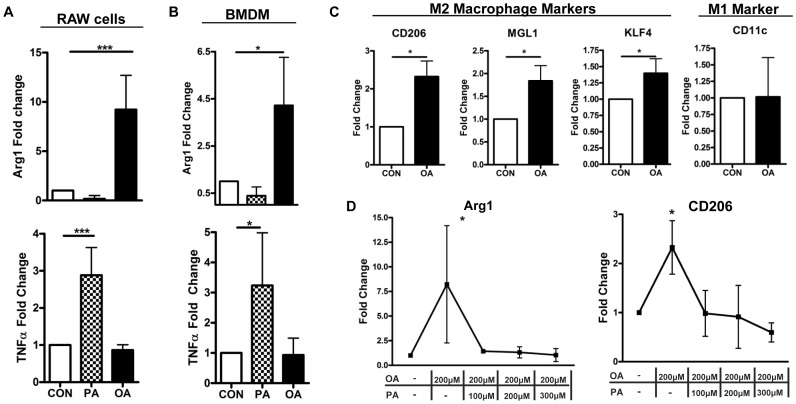
Oleic acid induces M2 macrophage markers inArginase-1 (Arg1) and TNFα gene expression fold change from (A) RAW 264.7 macrophages or (B) bone marrow derived macrophages (BMDM) cultured overnight with oleic (OA) or palmitic (PA) acid (500 µM). (N = 3,4) (C) CD206, MGL1 and KLF4 gene expression fold change in RAW 264.7 macrophages following overnight culture in OA (500 µM). (D) Arg1 and CD206 gene expression fold change from RAW 264.7 macrophages cultured in OA (200 µM) and PA (as labeled). Control cells were cultured in BSA and ethanol. (N = 3).